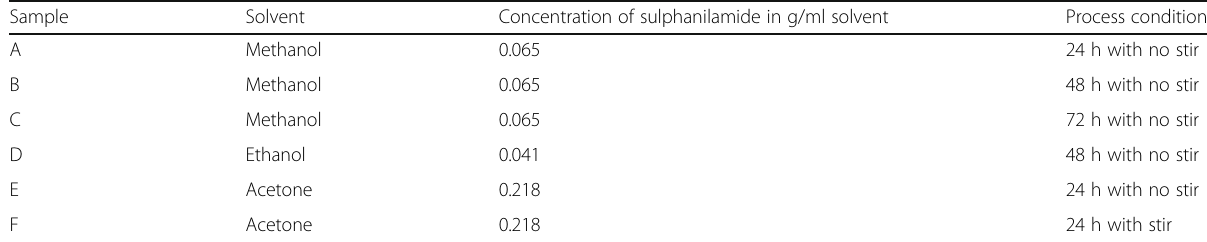
Table 2 Few of the crystal samples obtained by Solvent Evaporation method